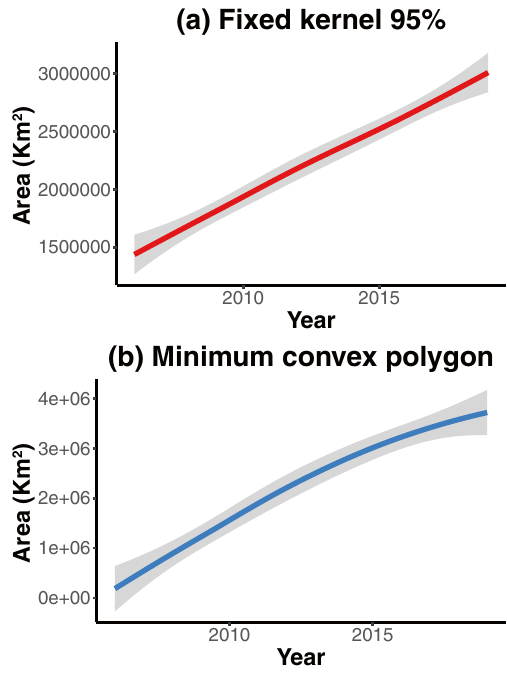
Figure 2. Bombus terrestris occupied area over time (smoothed